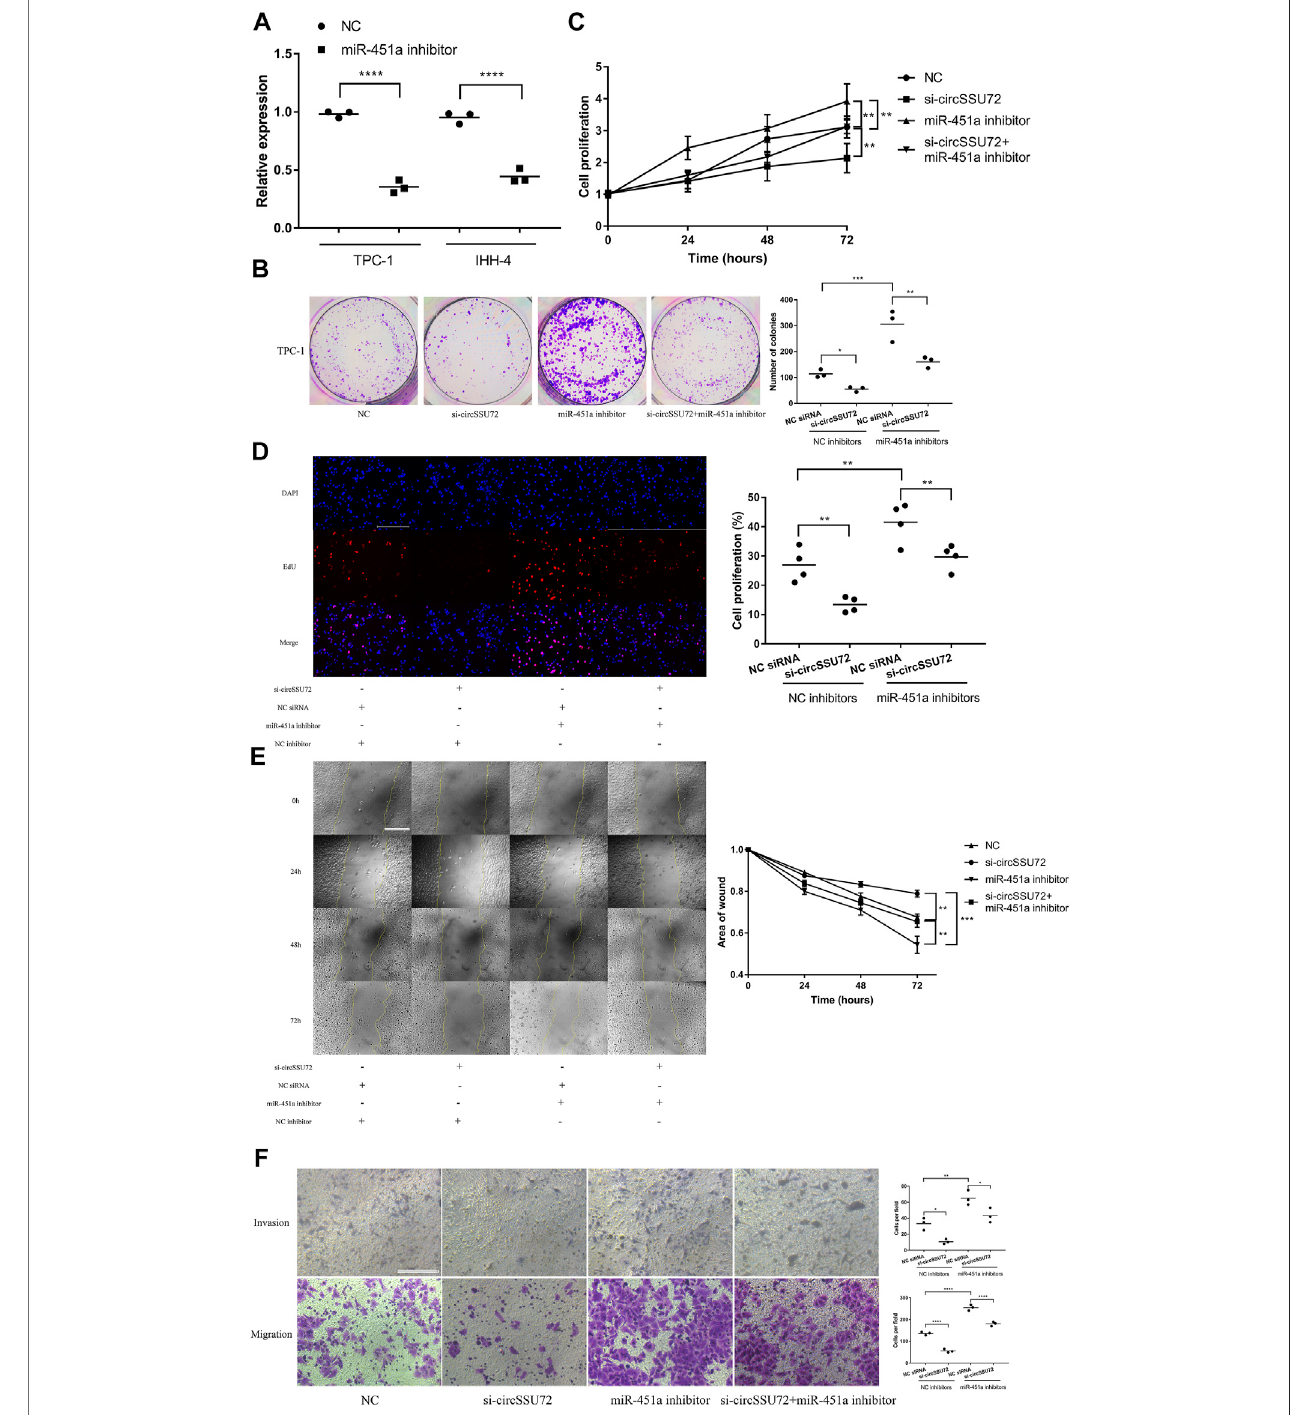
FIGURE4| The silenceofcircSSU72 inhibited PTC cell proliferation, migration, and invasionbytargetingmiR-451a. (A) Theexpression ofmiR-451a inTPC-1 and IHH-4 cells with the transfection of miR-451a inhibitor ( n = 3). (B) Colony formation assay of the cell proliferation ability in TPC-1 cell transfected with si-circSSU72 and miR-451ainhibitor( n =3). (C) CCK8assaytoassessthein fl uenceofcircSSU72andmiR-451aonTPC-1cell( n =3). (D) EdUassayofthecellproliferationabilityinTPC-1 cell transfected with si-circSSU72 and miR-451a inhibitor (scale bar = 100 um, n = 4). (E) Scratch wound healing assays in transfected TPC-1 cell (scale bar = 200 um, n = 3). (F) Transwell invasion and migration assay in transfected TPC-1 cell (scale bar = 100 um, n = 3). * p < 0.05; ** p < 0.01; *** p < 0.001; **** p < 0.0001.